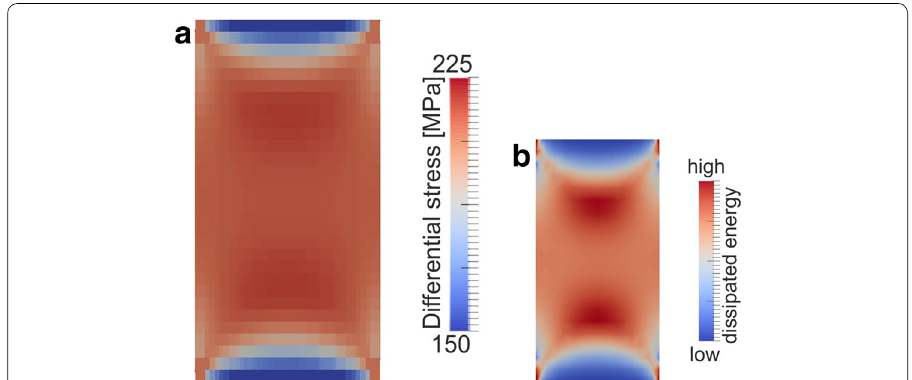
Fig. 6 a Exemplary differential stress distribution, before maximum stress is reached, for Tennenbach Sandstone with a confinement of 50 MPa simulated with REDBACK. b The energy dissipation for the same